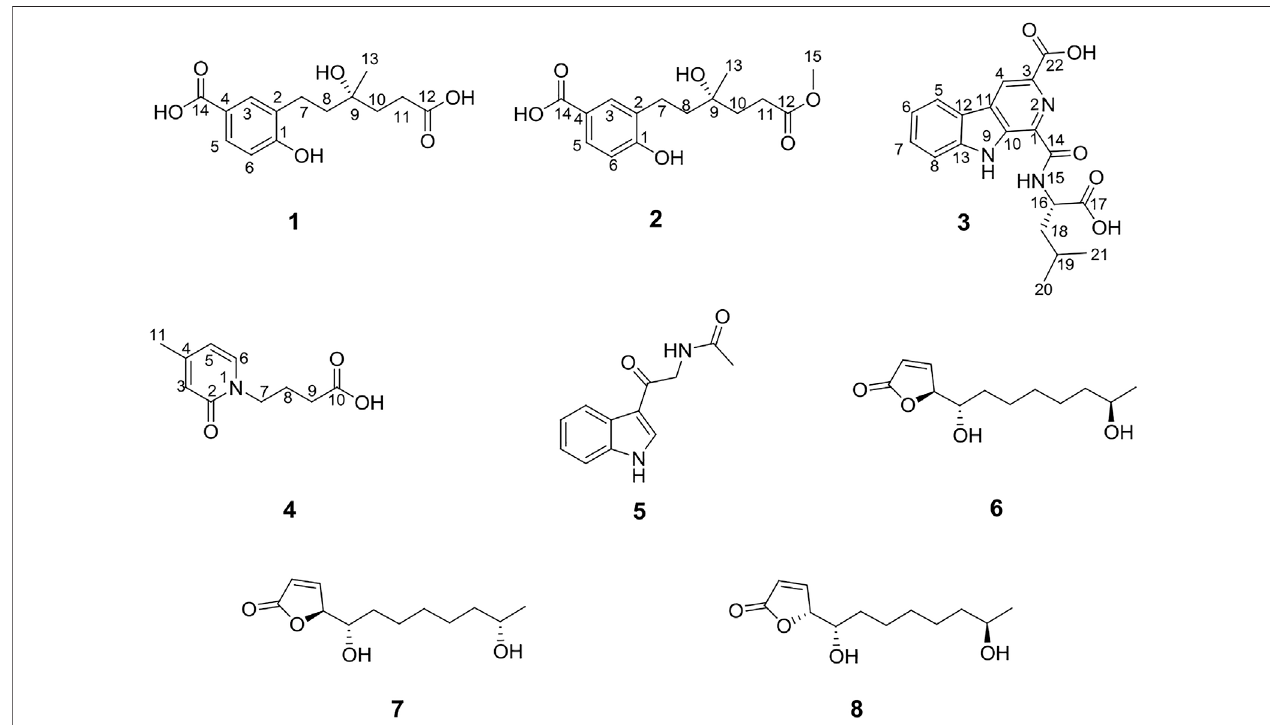
FIGURE 1 | Structures of compounds 1 – 8 .